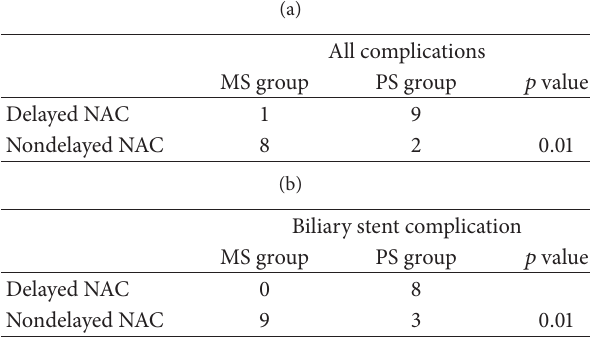
Table 2: Neoadjuvant chemotherapy (NAC)